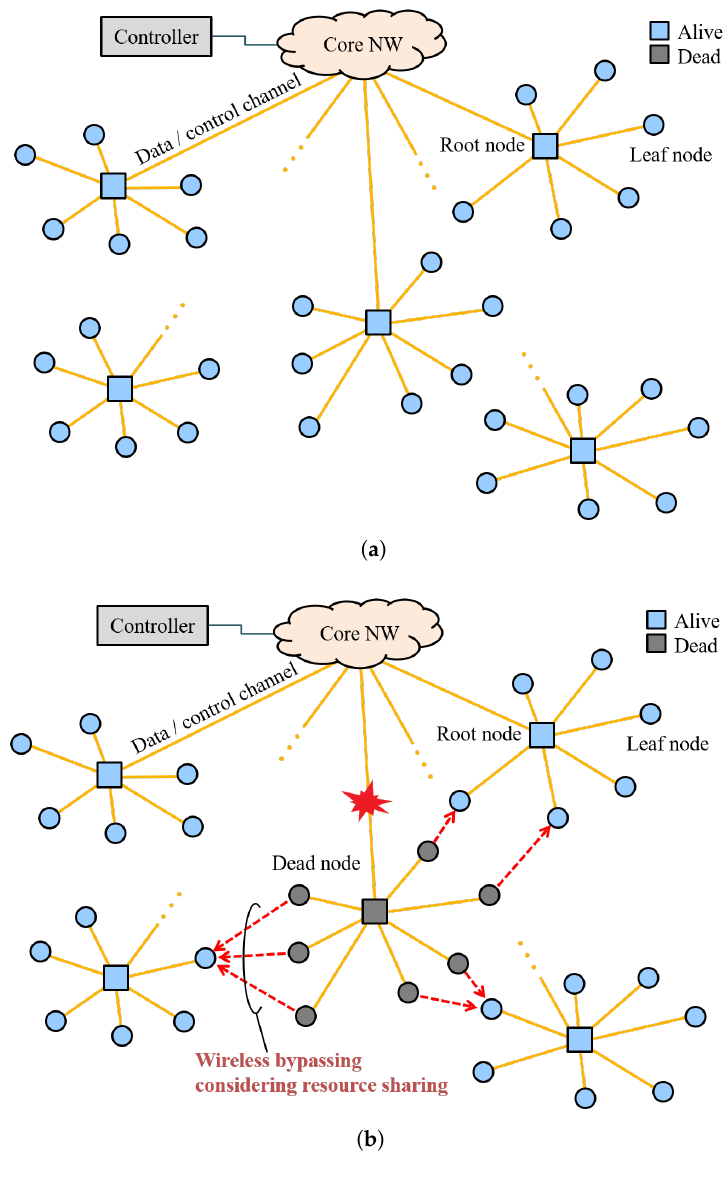
Figure 1. Concept of the NeCo system: ( a ) normal period; and ( b ) after